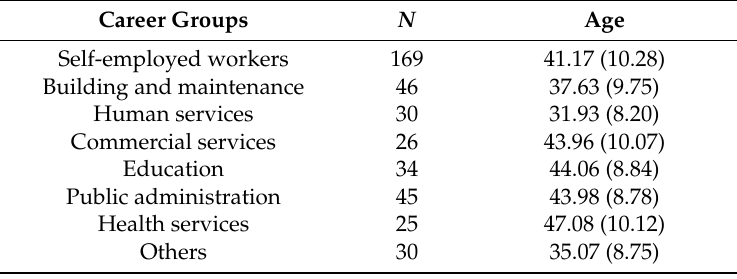
Table 1. Subject characteristics in relation to their occupation.